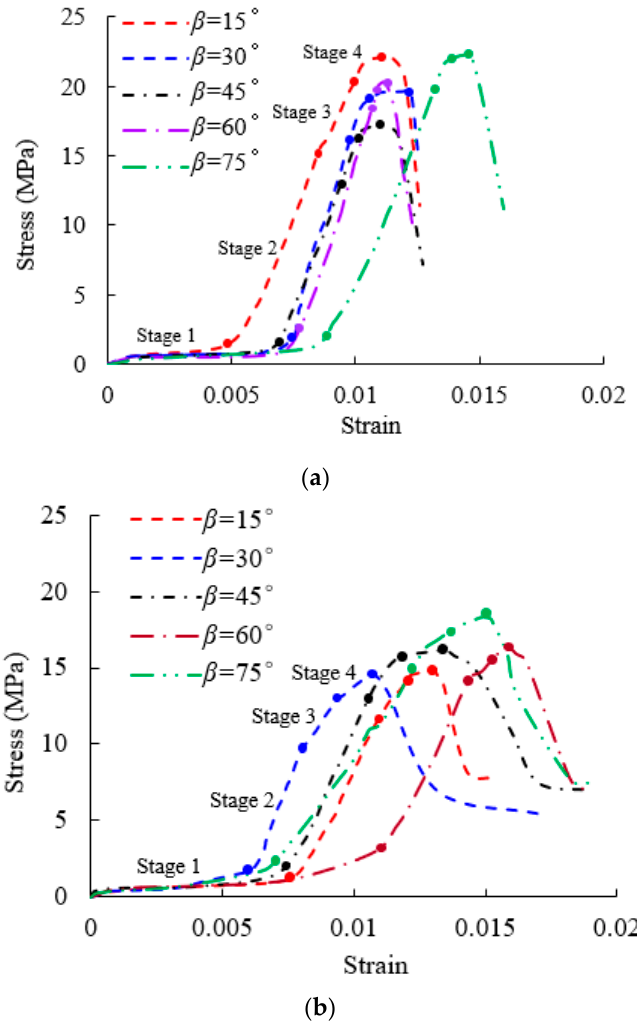
Figure 3. Stress–strain curves of concrete specimens with different crack angles. ( a ) Crack width = 0.5 mm; ( b ) Crack width = 3.0 mm.